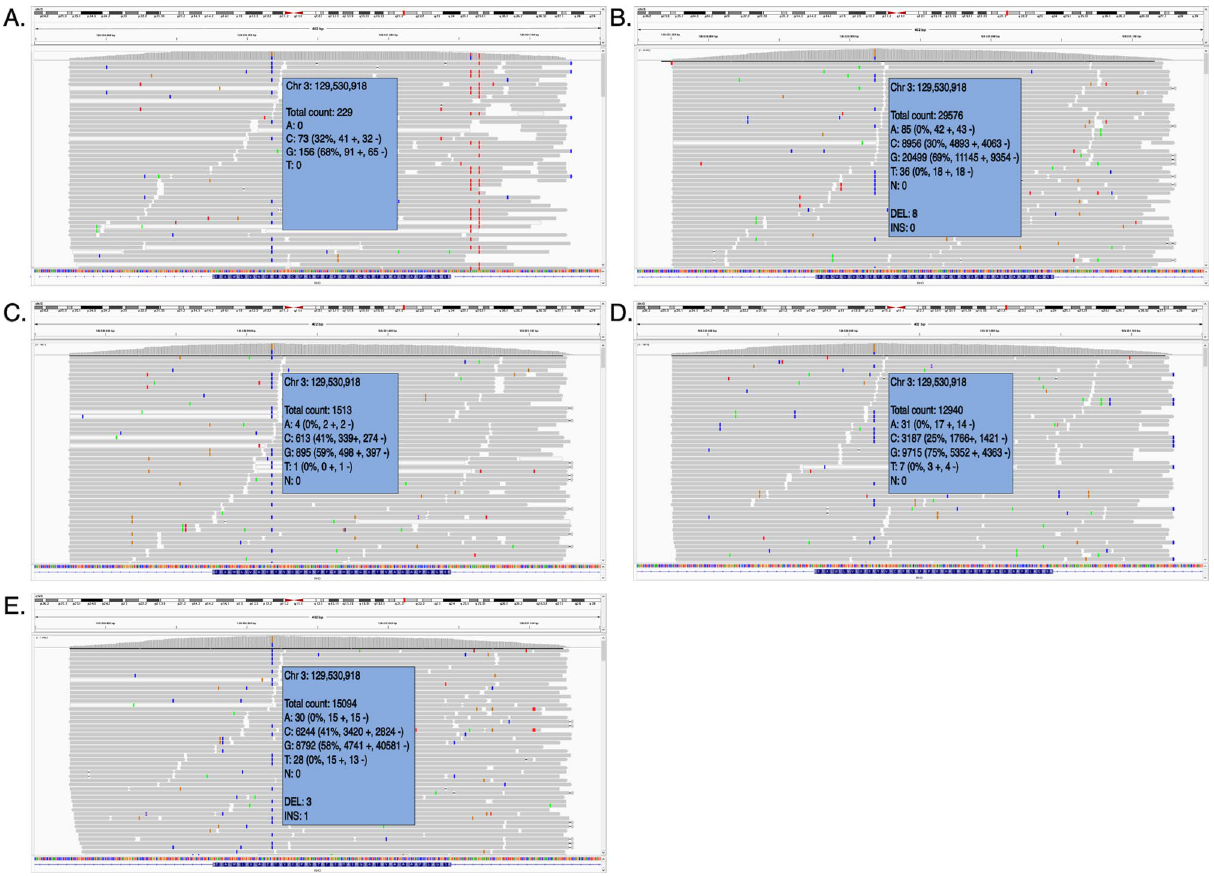
Figure 5. Mosaicism in multiple tissue types. Massively parallel sequencing reads visualized in the Integrative Genomics Viewer (IGV), showing the RHO variant c.404G > C p.(Arg135Pro) in a mosaic state in multiple tissues. ( A ) blood sample 1: variant allele frequency (VAF) of 31,97,279%. ( B ) blood sample 2: VAF of 30,4457%. ( C ) buccal mucosa sample 1: VAF of 40,9042%. ( D ) buccal mucosa sample 2: VAF of 25,0641%. ( E ) Sample of hair follicle: VAF of 41, 72,123%.